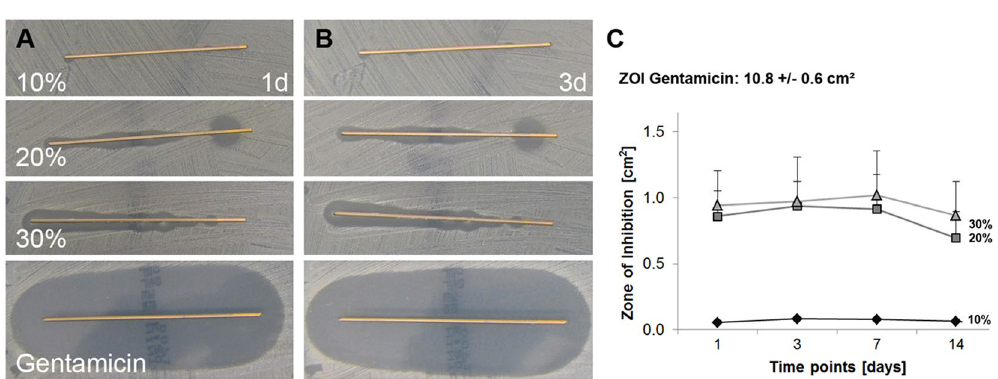
Figure 8. Zone of inhibition (ZOI) test of the AMP2 or gentamicin incorporated at different concentrations into a poly(D,L-lactide) coating (n = 3). Gentamicin was used in 10% w/w PDLLA, AMP2 ranged from 10, 20 to 30% w/w PDLLA. ( A ) ZOI after 1 day, ( B ) ZOI after 3 days, ( C ) Quantification of the ZOI, n = 3. Data are shown as means with standard